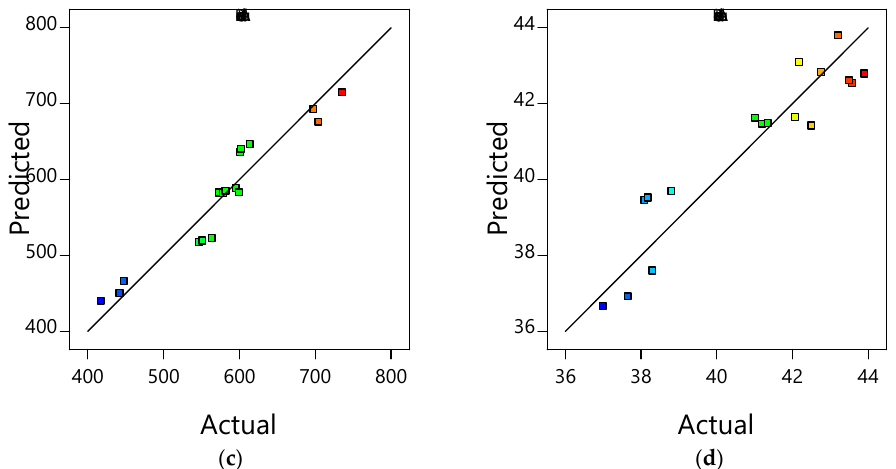
Figure 1. Plots of predicted versus actual values for: ( a ) elongation, ( b ) tensile strength, ( c ) elastic modulus, and ( d ) crystallinity.